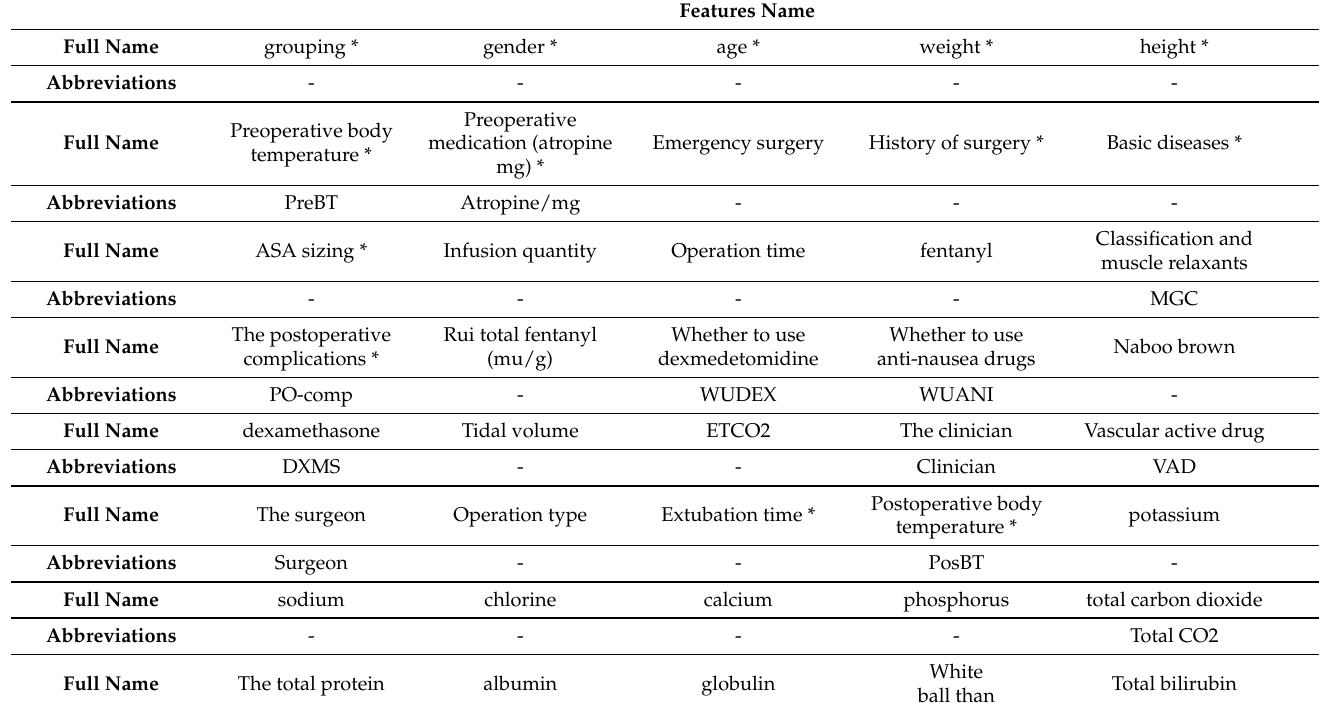
Table A1. Full names and corresponding abbreviations of the collected features. Features marked with * are from dataset A, conversely from dataset